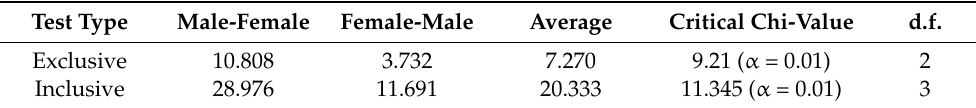
Table 11. Frequencies of student’s results and actions by gender groups.